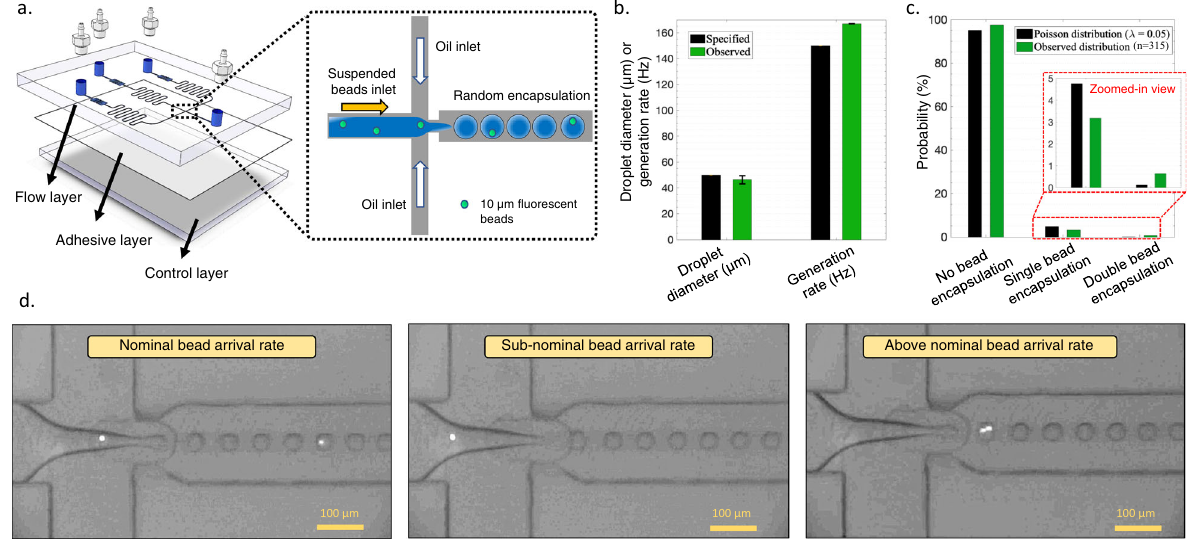
Fig. 8 Single-cell encapsulation with user-speci fi ed performance. a The desired performance of 50 μ m and 150 Hz was speci fi ed and the design suggested by the tool was fabricated. Polystyrene beads 10 μ m in size were used as cell surrogates and were suspended in DI water at a concentration given by the tool (922.9 beads/ μ l). b By setting the fl ow rates to the suggested values, a droplet diameter of 46.3 μ m at 167 Hz was achieved. c Within a total of 315 continuous events, 10 events of single-bead encapsulation, and 2 events of double-bead encapsulation were observed, which closely follows the Poisson distribution. d Snapshots of the experiment further emphasize the random but probabilistic nature of single-cell encapsulation. Coloring was adjusted for better